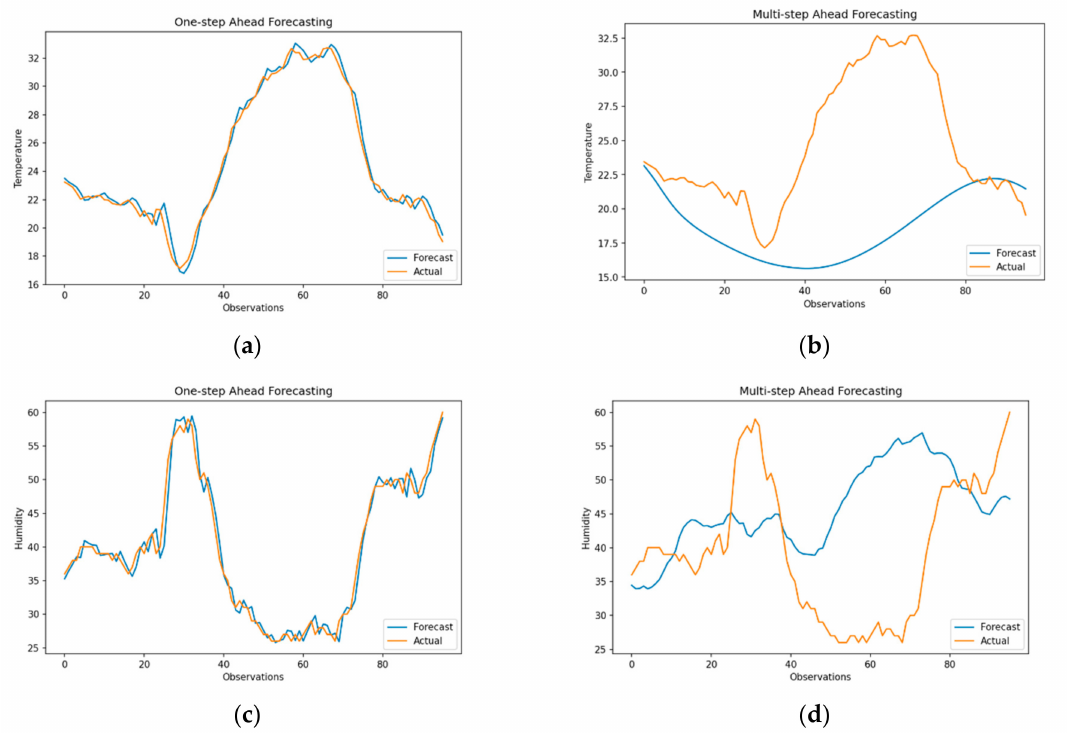
Figure 8. Forecast using Recurrent Neural Networks (RNN) ( a ) One-step ahead Temperature ( RMSE = 0.653) ( b ) Multi- step ahead Temperature ( RMSE = 5.581) ( c ) One-step ahead Humidity ( RMSE = 2.508) ( d ) Multi-step ahead Humidity ( RMSE = 27.703) ( top-left, top-right, bottom-left, bottom-right